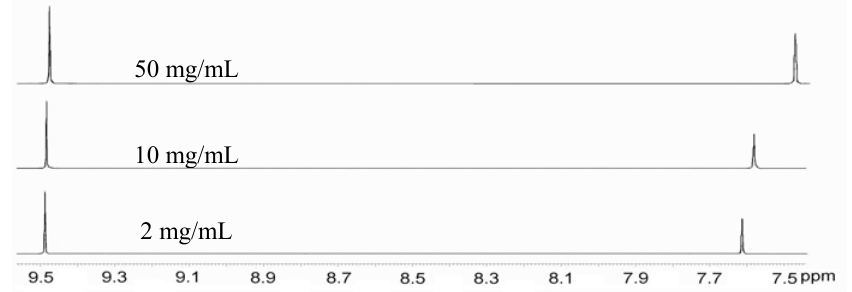
at different concentrations. 3